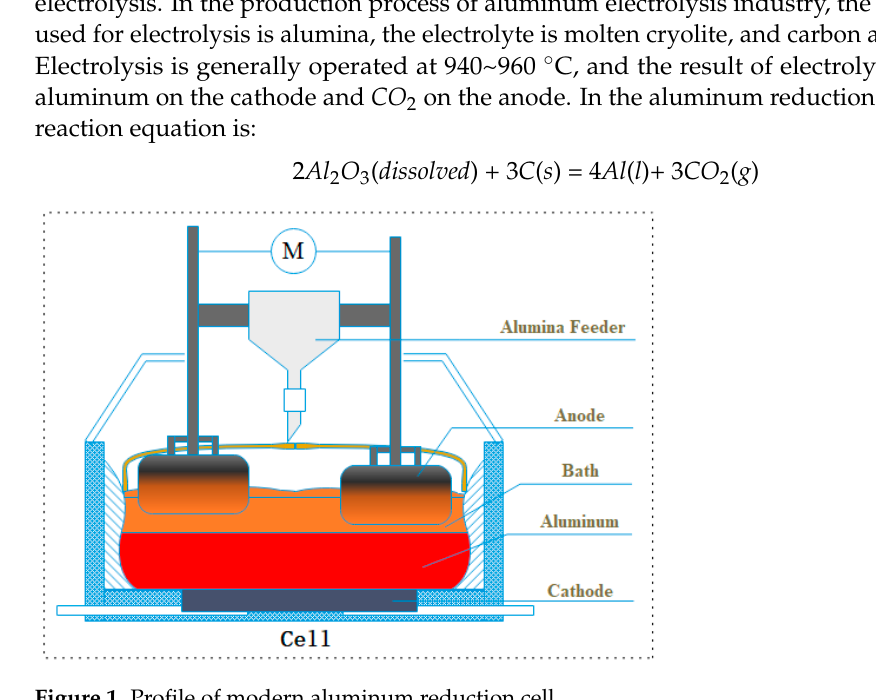
Figure 1. Profile of modern aluminum reduction cell.